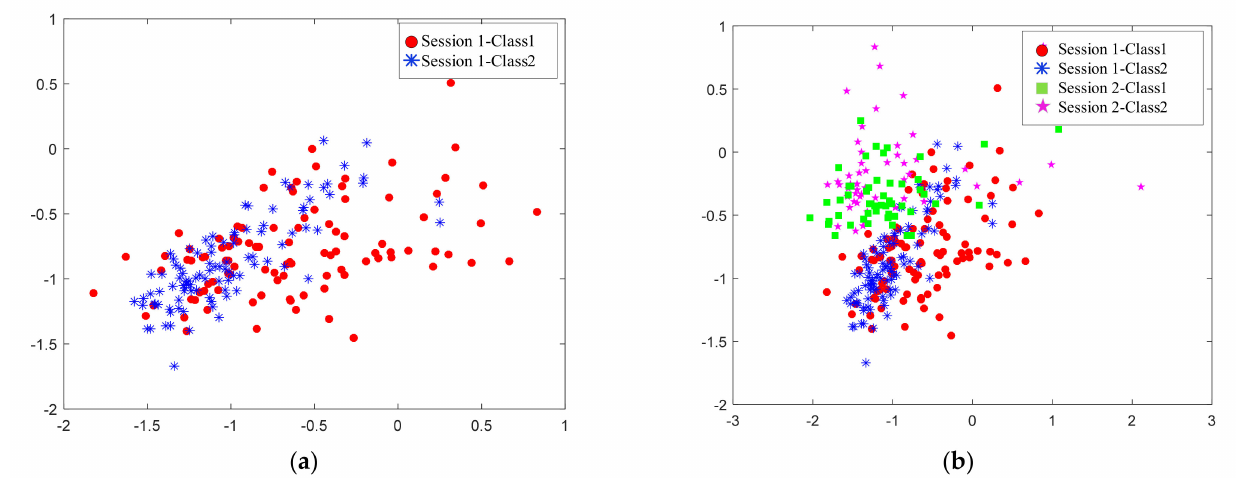
Figure 2. The feature distribution comparison of Subject 46. The features were extracted by a common spatial pattern (CSP). ( a ) The distribution of features for session 1; ( b ) The distribution comparison of features for Sessions 1 and